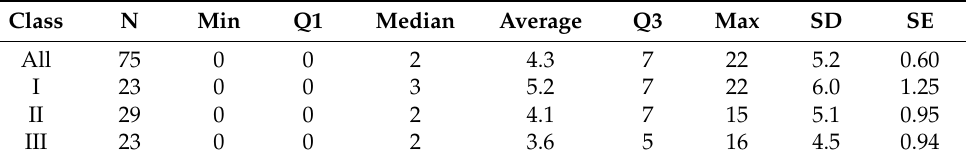
Figure 6. The distribution of the left transversal condylar inclination (TCI) coefficient value. Num- bers represent patients’ IDs. Table 4. Transversal condylar inclination (TCI) of the right TMJ.